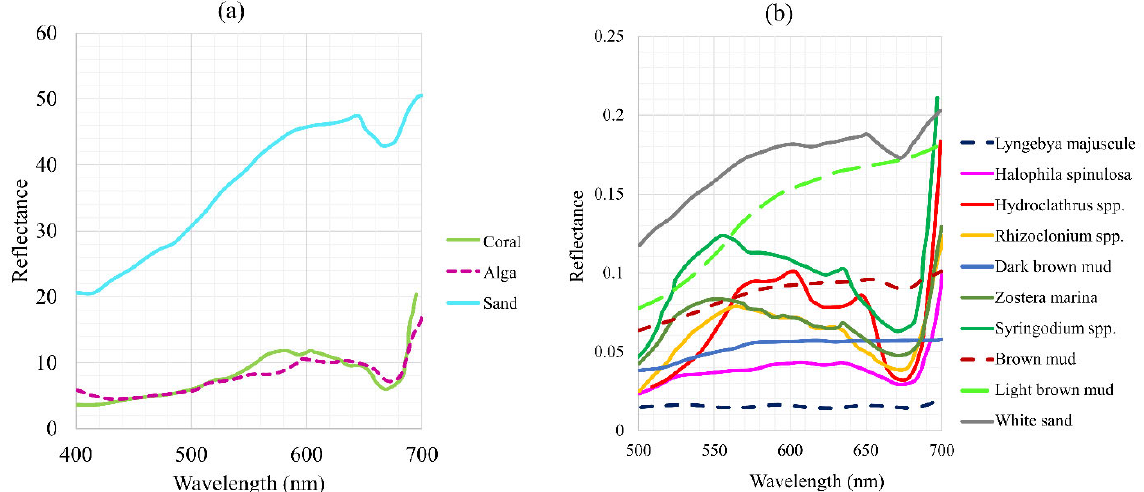
Figure 13. Spectral signatures of different ( a ) CRs [349] and ( b ) AVs